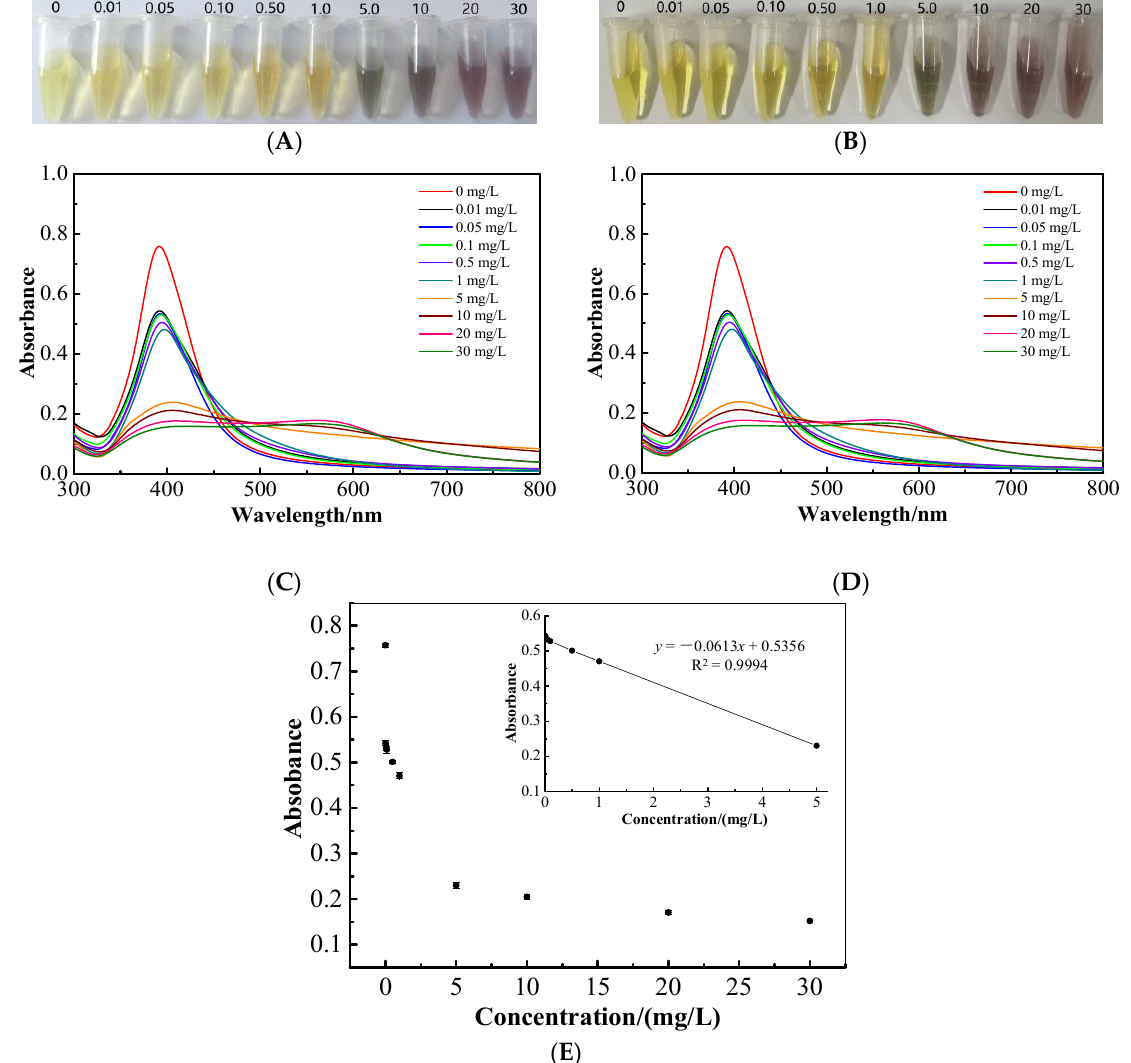
Figure 6. Representative photographic image of colorimetric sensing with ( A ) different concentrations (mg/L) of cartap standard solutions and with ( B ) Fe 3 O 4 @mSiO 2 @MIPs extracts of bottled green tea beverage spiked with different concentrations (mg/L) of cartap; average UV–vis absorption spectra of AgNPs ( C ) in the presence of different concentrations of cartap and ( D ) in the presence of Fe 3 O 4 @mSiO 2 @MIPs extracts of bottled green tea beverage spiked with different concentrations of cartap; ( E ) plot of the average absorption values at 392 nm versus different concentrations of cartap standard solutions ( n = 3).